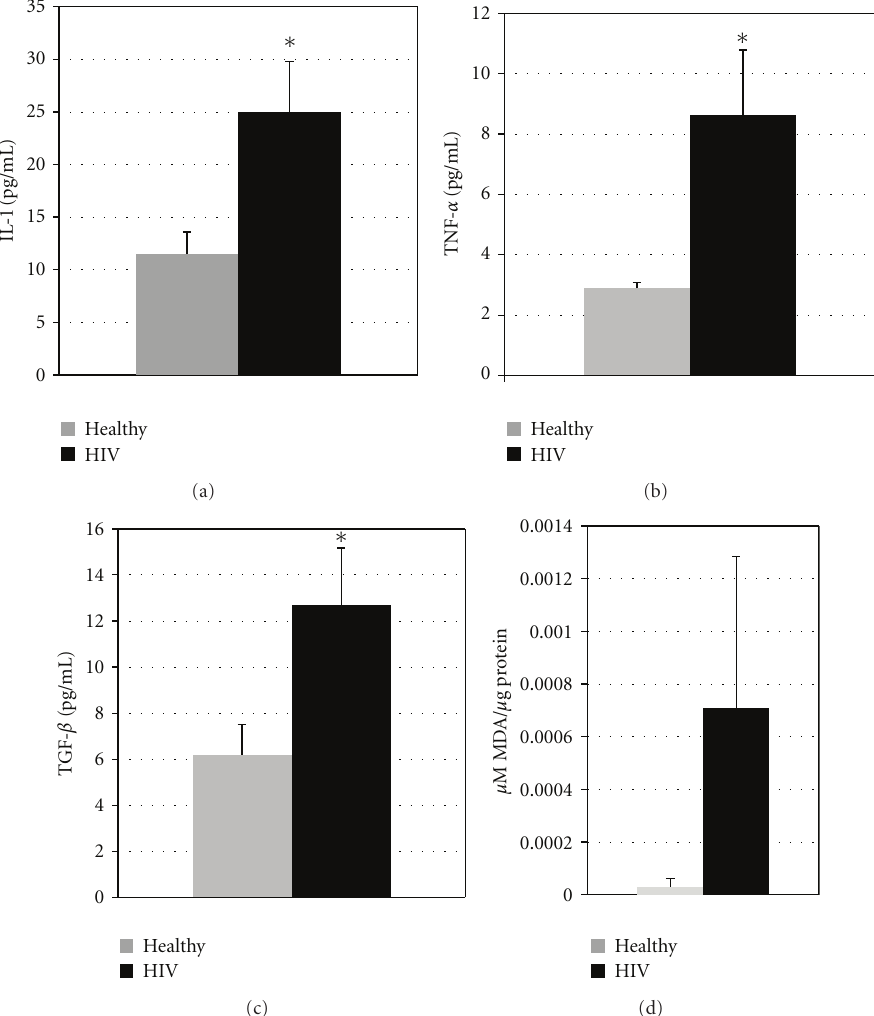
Figure 3: (a) Assay of IL-1 in macrophage culture supernatants from HIV-infected and healthy subjects . Supernatants from human monocyte- derived macrophages (from healthy and HIV-infected individuals) were assayed for the levels of IL-1 using assay kit from ebioscience. Data in (a) denote means ± SE from eight healthy individuals and nine individuals with HIV infection ( ∗ P ≤ 0 . 05). (b) Assay of TNF- α in macrophage culture supernatants from HIV-infected and healthy subjects . Supernatants from human monocyte-derived macrophages (from healthy and HIV-infected individuals) were assayed for the levels of TNF- α using assay kit from ebioscience. Data in (b) are means ± SE from eight healthy individuals and nine individuals with HIV infection ( ∗ P ≤ 0 . 05). (c) Assay of TGF- β in macrophage culture supernatants from HIV-infected and healthy subjects . Supernatants from human monocyte-derived macrophages (from healthy and HIV-infected individuals) were assayed for the levels of TGF- β using assay kit from ebioscience. Data in (c) represent means ± SE from eight healthy individuals and nine individuals with HIV infection ( ∗ P ≤ 0 . 05). (d) Assay of MDA in macrophage lysates from HIV-infected and healthy subjects. Free radical levels in macrophage lysates from healthy subjects and individuals with HIV infection were determined by measuring the levels of MDA using a colorimetric assay kit from Cayman. Results in (d) are averages of data collected from five healthy subjects and five individuals with HIV infection. These elevated MDA concentrations are indicative of elevated free radical concentrations. High standard error values observed in HIV-infected subjects (a–d) are likely due to the varying stages of HIV infection and antiretroviral treatment in the HIV-infected